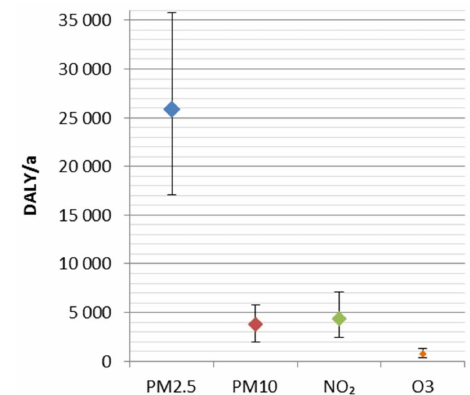
Figure 4. Combined uncertainties from exposure and relative risks for disease burden of ambient air pollution as disability-adjusted life years (DALY) in 2015 in